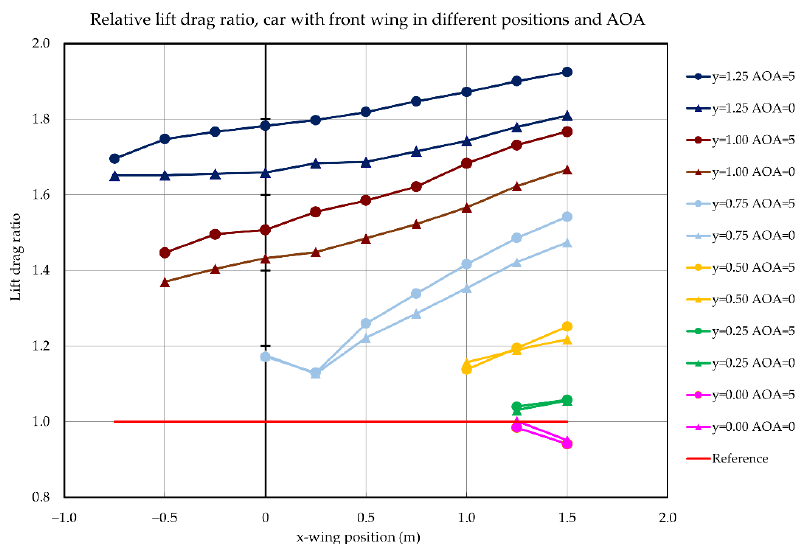
Figure 24. Variations in the ratio of the lift force to the aerodynamic drag force compared to the ratio for a car without a wing, as a function of the position of the wing relative to the body and as a function of the angle of attack (AOA).